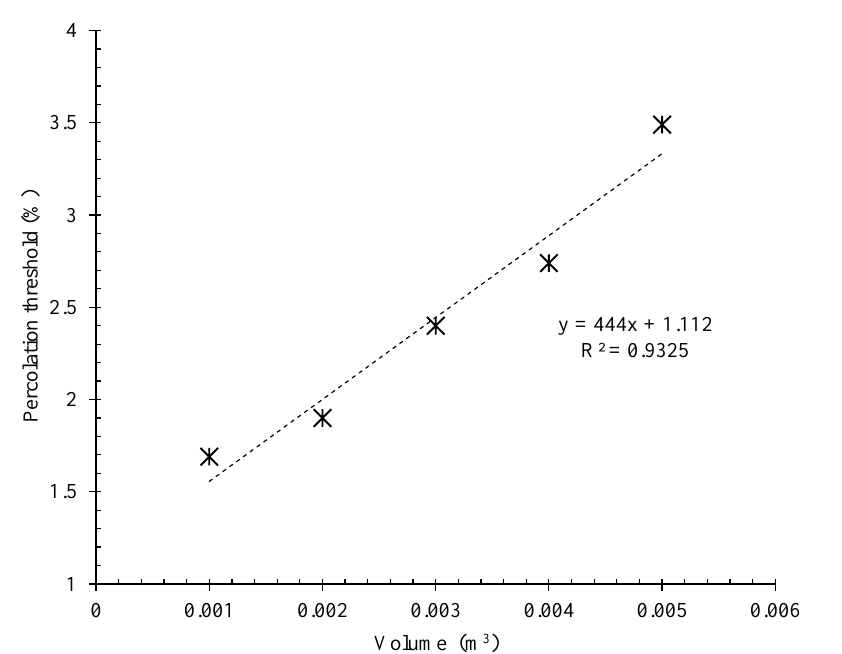
Figure 9. Relation between electrical percolation threshold and matrix volume of CNT/GNP rein- forced specimens with different lengths.